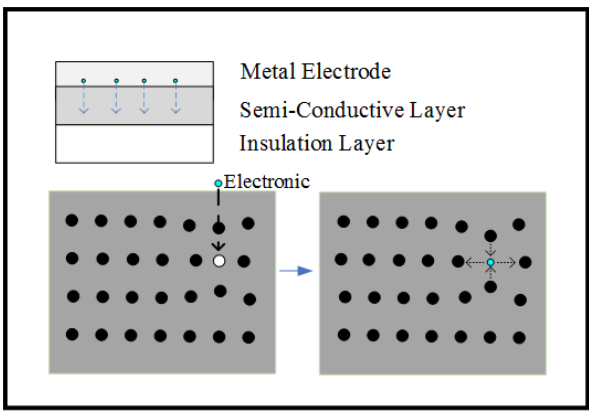
Figure 14. Schematic diagram of electron trapping.